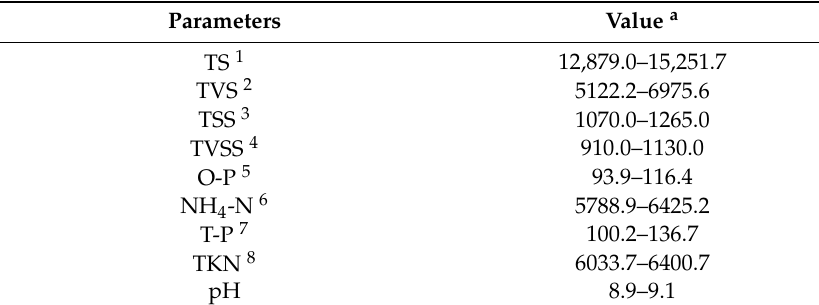
Table 1. Characteristics of swine wastewater.